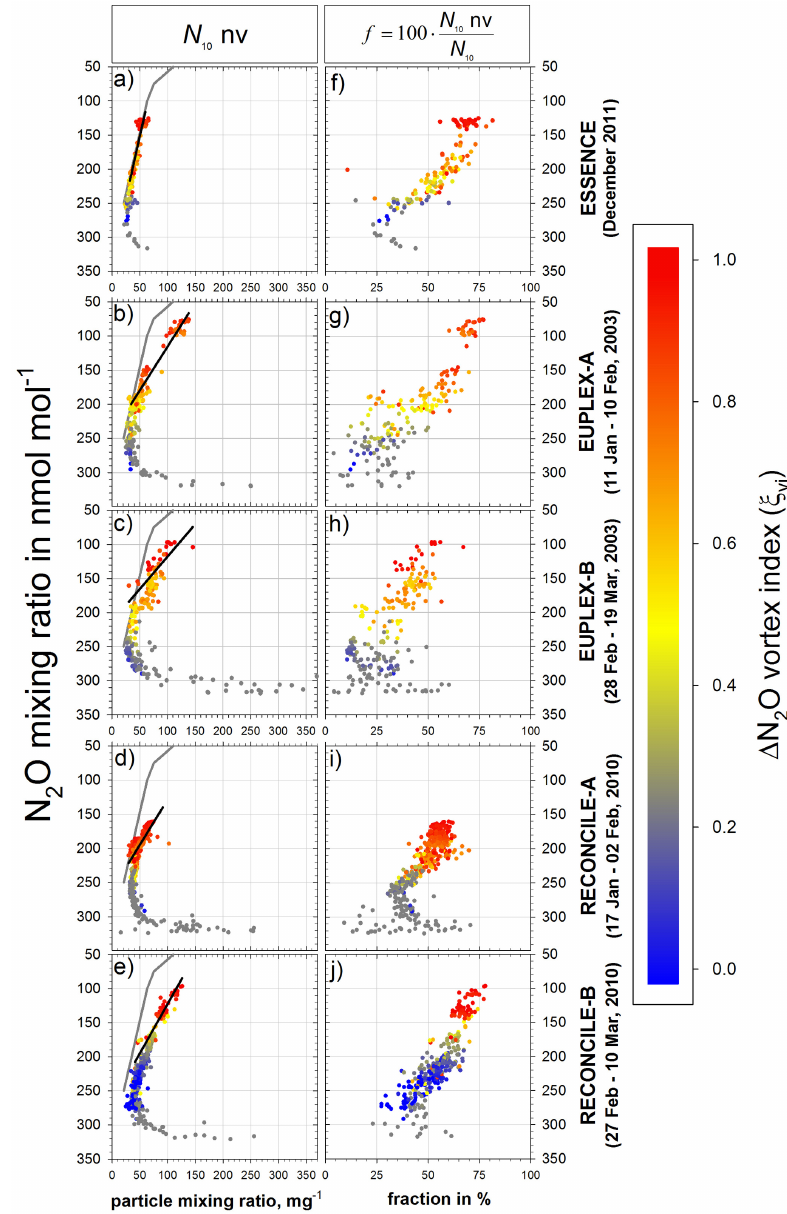
Figure 6. Mixing ratio of non-volatile particles N 10 nv and their fractional contribution f to measured total aerosol abundance as function of N 2 O mixing ratio. The data points are colored according to the (cid:49) N 2 O vortex index ξ vi . Data points are designated in gray if measurements occurred at (cid:50) -levels below 400K for which inside or outside vortex apportioning is not unambiguous (cf. Sect. 2). For data measured inside the vortex ( ξ vi > 0.75) the black lines indicate a linear correlation. Alternatively, for N 2 O below 250nmolmol − 1 , curves representing a canonical correlation are provided as gray lines with the ESSenCe data (early winter) referring to conditions as closest to the pre-vortex situation (a) . The same early winter climatology provides a reference for comparison to data from measurements in progressed winter ( b to e